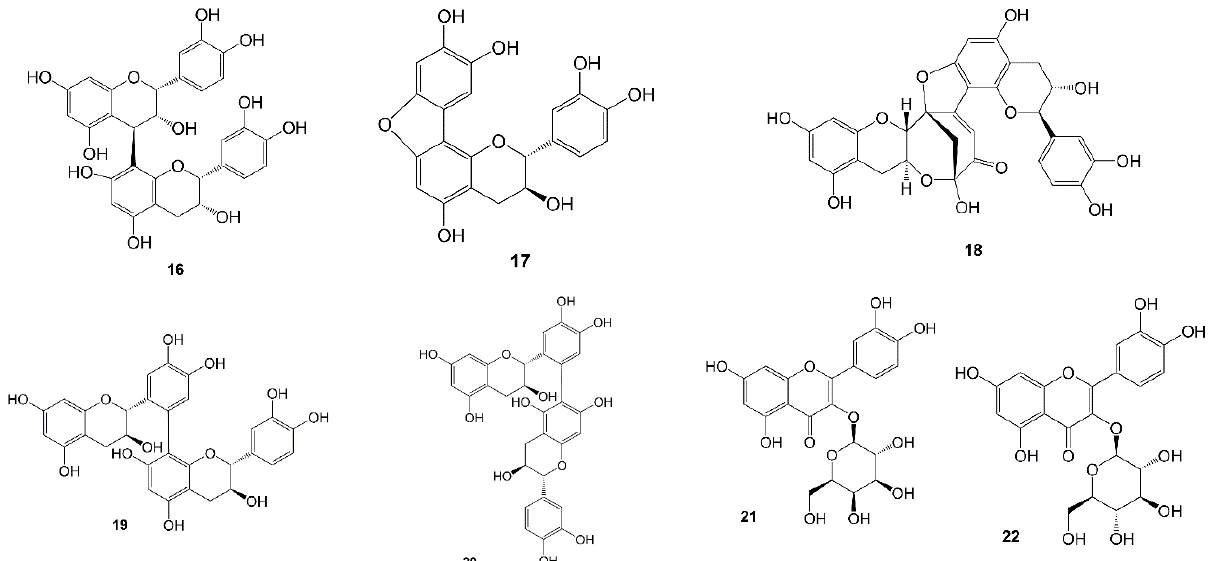
Figure 2. Chemical structure of flavonoid ( 1 – 5 ), dimeric flavonoid compounds ( 6 – 20 ) and flavonoid- glycosides compounds ( 21 , 22 ) from Uncharia gambir Roxb.